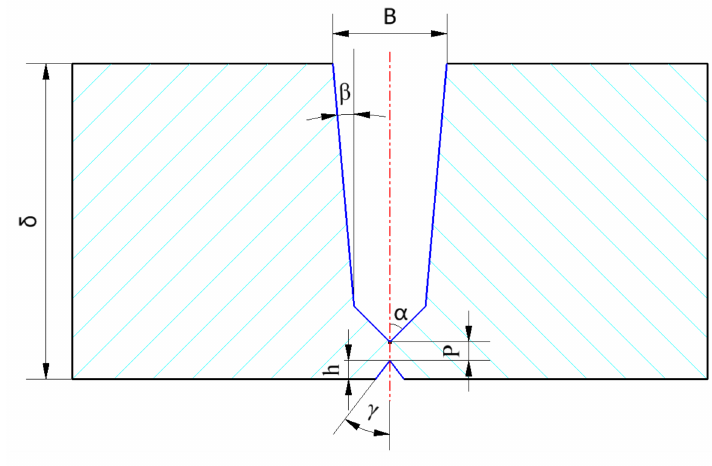
Figure 3. Schematic diagram of narrow gap compound groove.